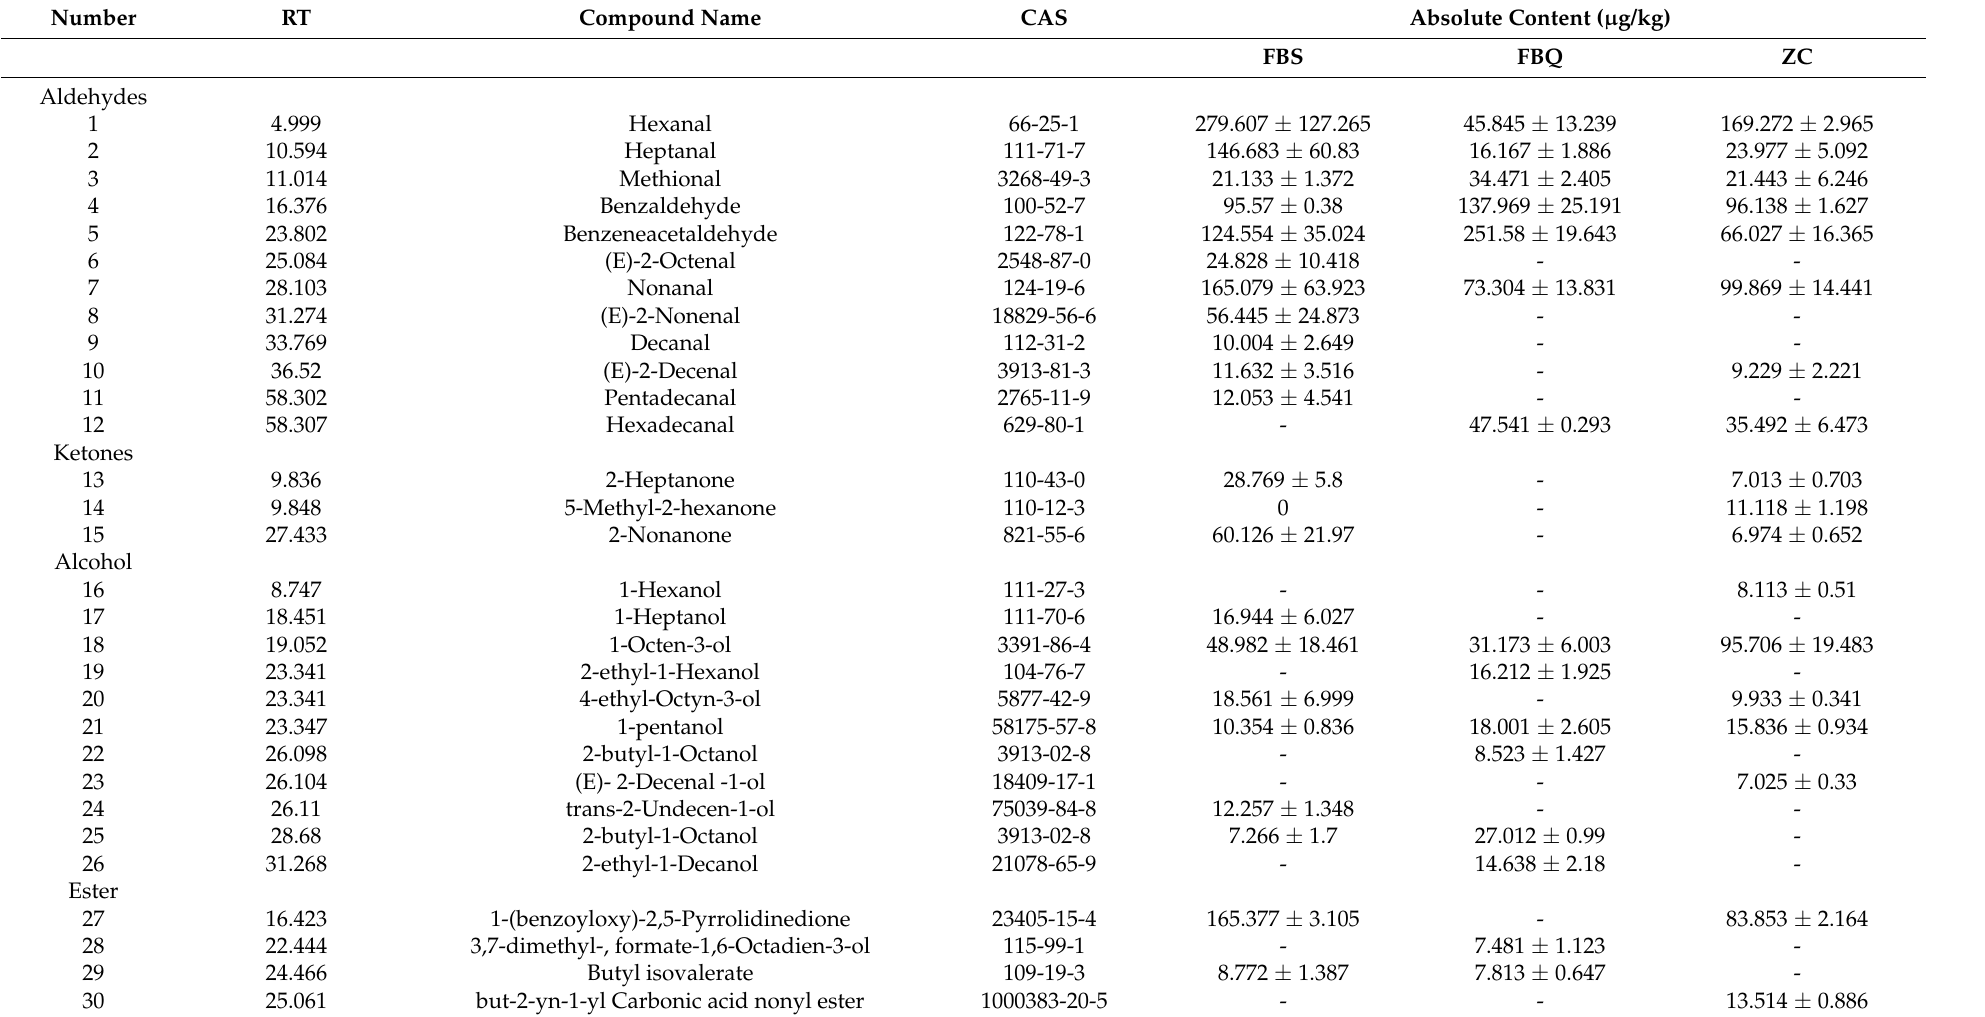
Table 4. Types and contents of flavor compounds in Mianning